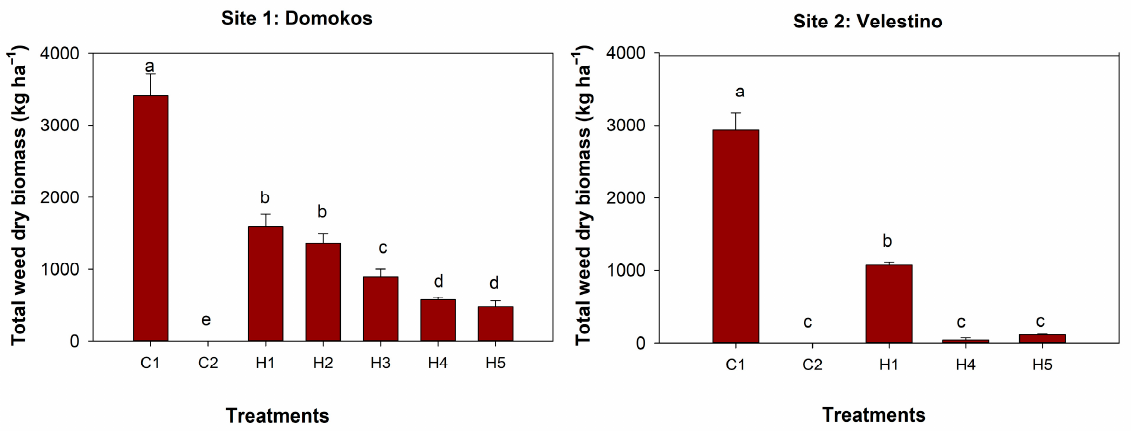
Figure 4. Herbicide treatment (C1: untreated control, C2: weed-free control, H1: metsulfuron-methyl + bensulfuron-methyl, H2: pyroxsulam/florasulam + 2,4-D, H3: aminopyralid + florasulam, H4: bromoxynil + 2,4-D, and H5: halauxifen-methyl + florasulam) effects on total weed dry biomass (kg ha − 1 ) at two sites. Values are presented as means of three replicates ± standard deviation. Mean values followed by different letters have statistically significant differences according to Duncan’s multiple range test at p < 0.05. F values of ANOVA: F = 179.729 ***(Site 1: Domokos) and F = 380.623 *** (Site 2: Velestino). *** significant at p < 0.001.